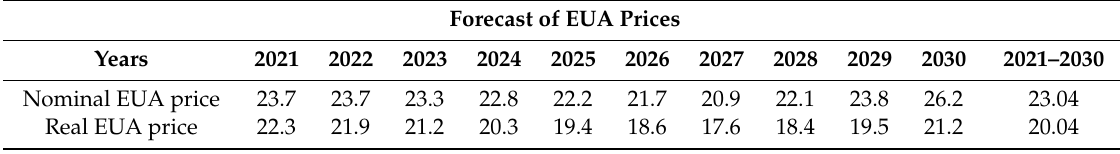
Table 5. Current forecast of prices of EUA allowances in 2021–2030 according to Thomson Reuters (nominal prices, real, in